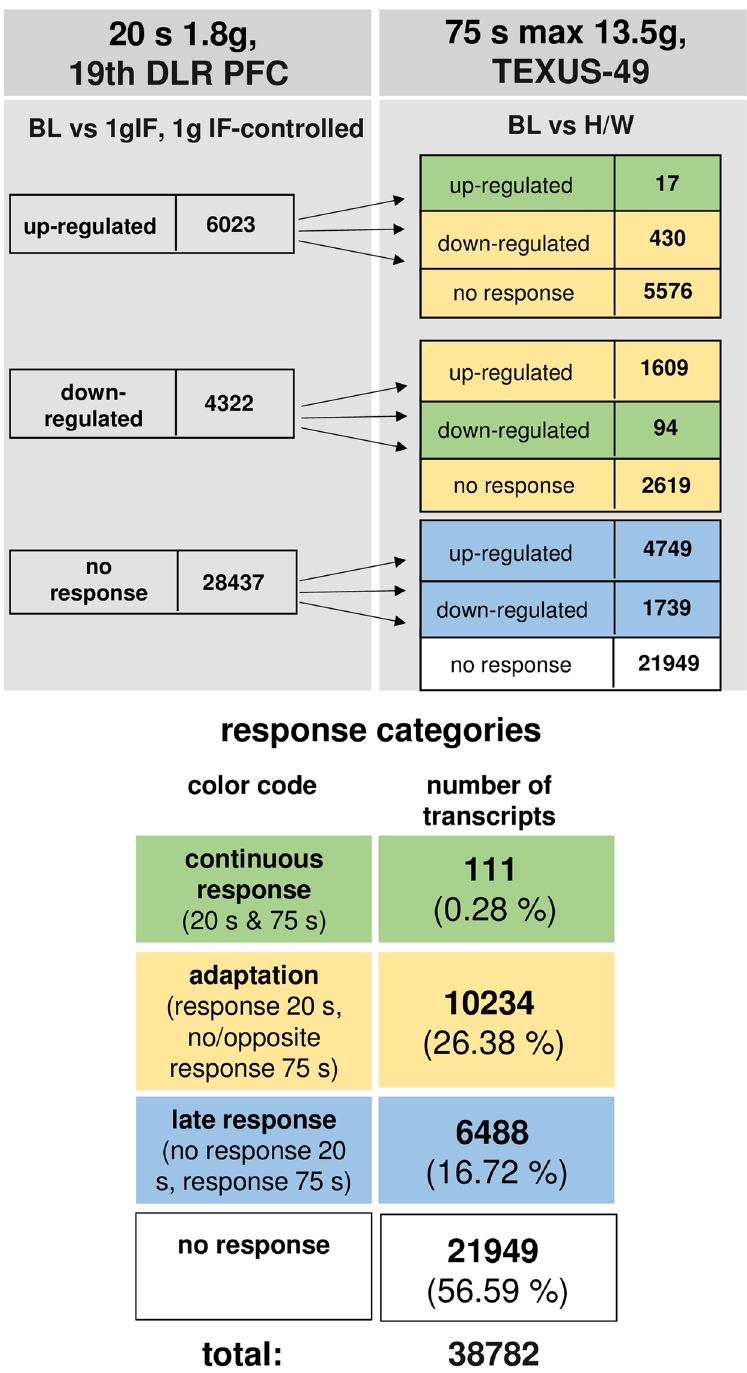
Figure 10. Time course of differential gene expression in hypergravity. Human myelomonocytic U937 cells were exposed to 20 s and 75 s of hypergravity. The numbers of annotated transcripts grouped according to their regulation after the two exposure times are shown. Continuous response means that annotated transcript are either up- or down-regulated at both time points. Adaption is either disappearance of the hypergravity induced effect or regulation in the opposite direction after 75 s. Late response is a regulation that only appears after 75 s. Most transcripts did not respond to hypergravity at both time